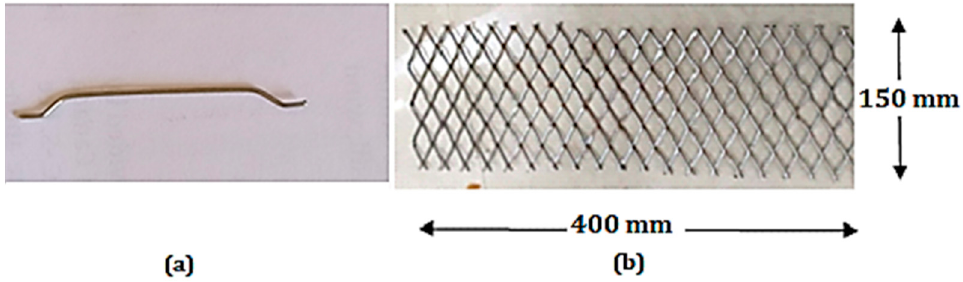
Figure 1. Details of fiber and EWM ( a ) Geometric shape of steel fiber and ( b ) EWM utilized in ferrocement panel under study.